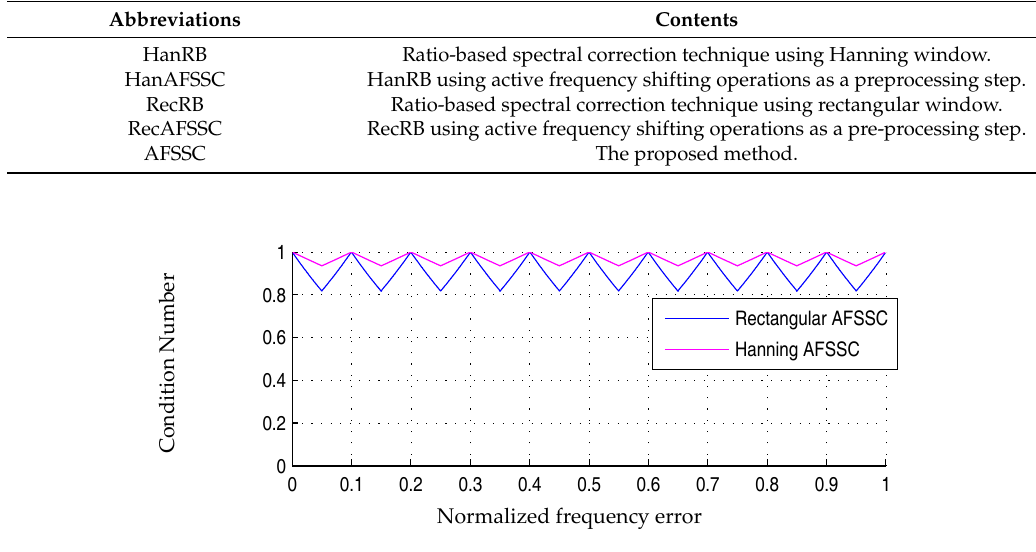
Figure 10. Condition numbers of rectangular-window-based and Hanning-window-based spectral correction methods enhanced by spectral interpolations.